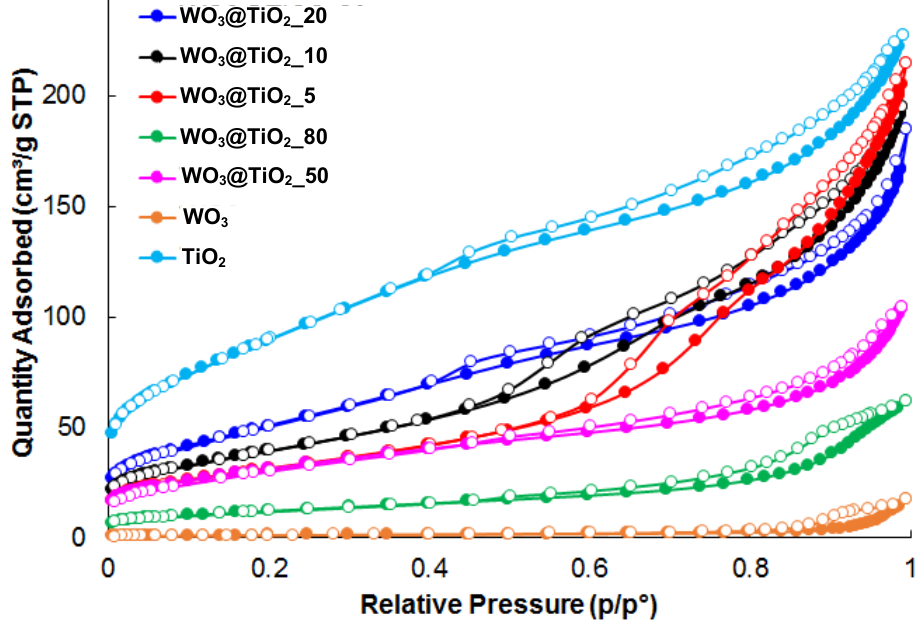
Table 1. Energy of band gap (eV), specific surface area, CBET, Vm, and mean pore diameter of the WO 3 /TiO 2 composites series calcined at 400 °C. * Surface area by BET equation (2-parameters), **